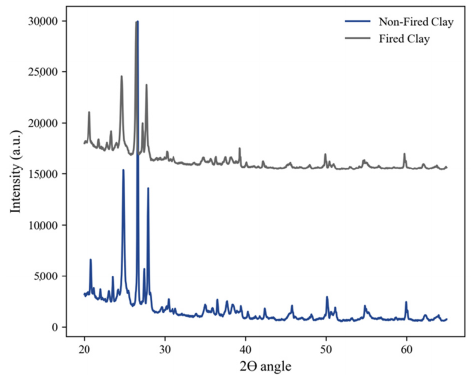
Figure 5. Porcelain clay XRD of non-fired and fired clay samples.